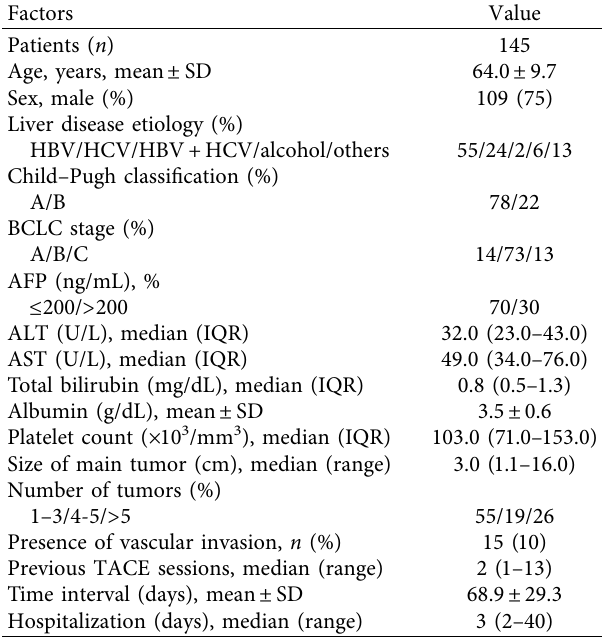
Table 2: Patient and tumor characteristics of the study participants who underwent repeated